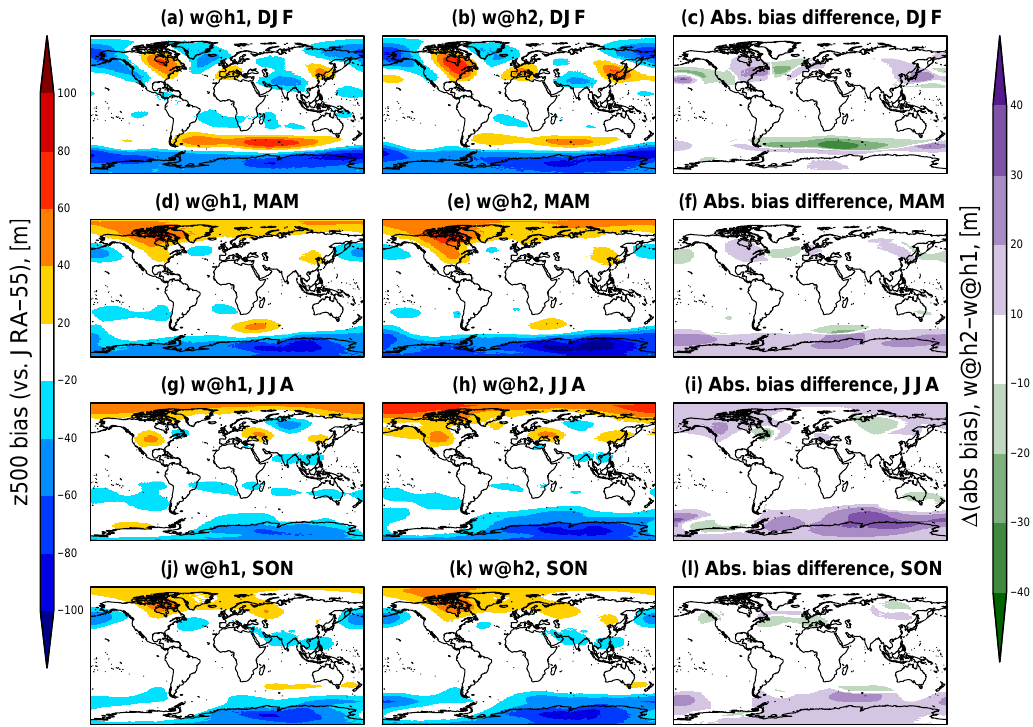
Figure 4. Same as Fig. 2 but for geopotential height at 500hPa with respect to the JRA-55 reanalysis.